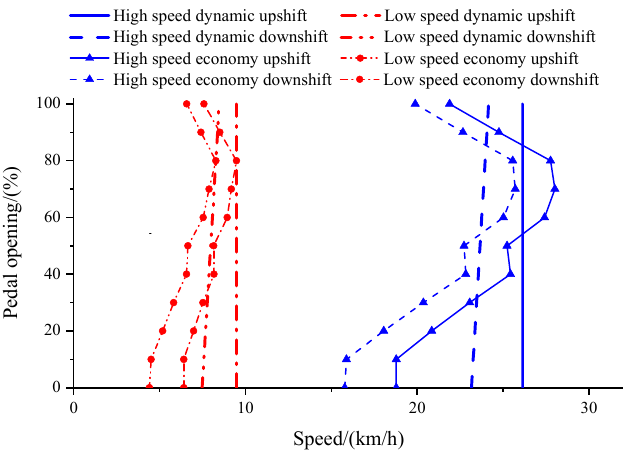
Figure 10. A comparison between optimal power and the economic shift rule.